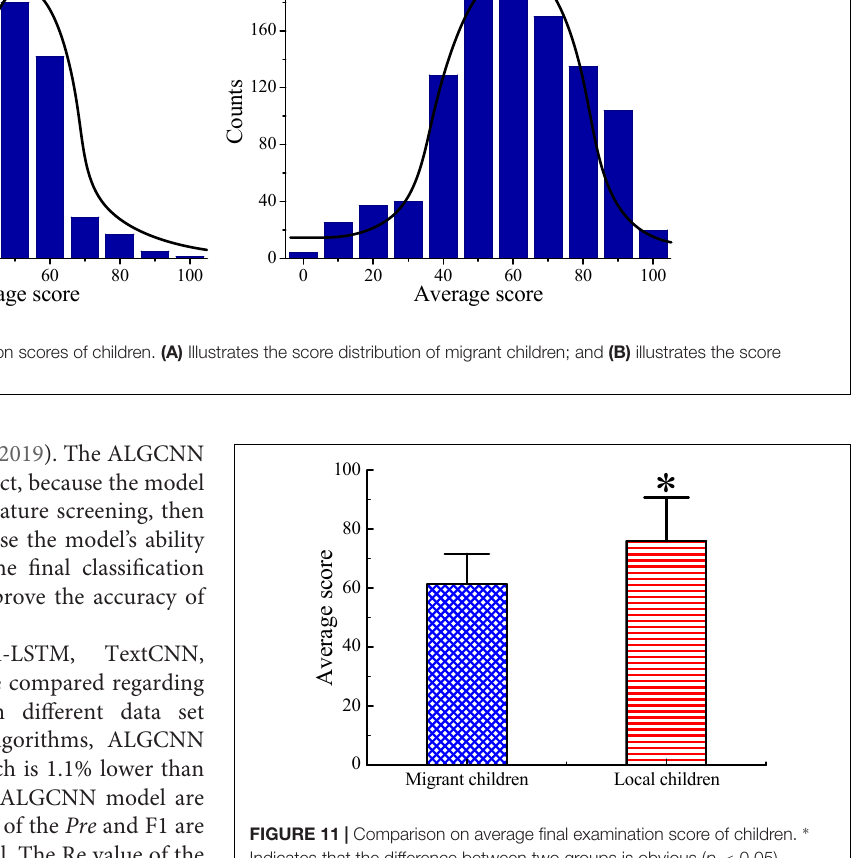
FIGURE 11 | Comparison on average final examination score of children. ∗ Indicates that the difference between two groups is obvious ( p < 0.05).